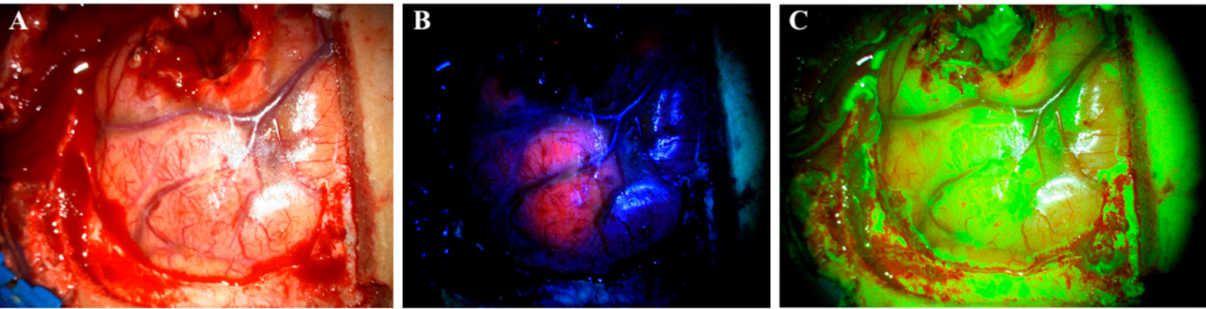
Figure 1. Visualization of a glioblastoma under a surgical microscope with different techniques. ( A ) white light. ( B ) 5-aminolevulinic acid. ( C ) sodium